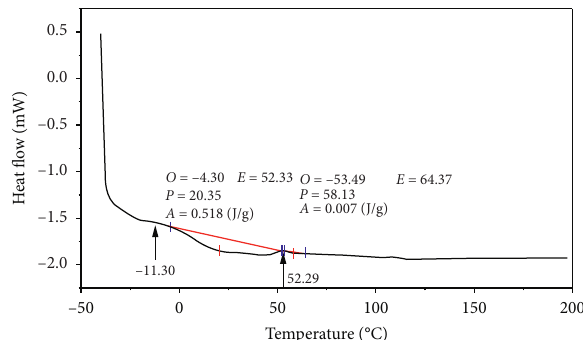
Figure 10: DSC results of activated rubber powder-modified